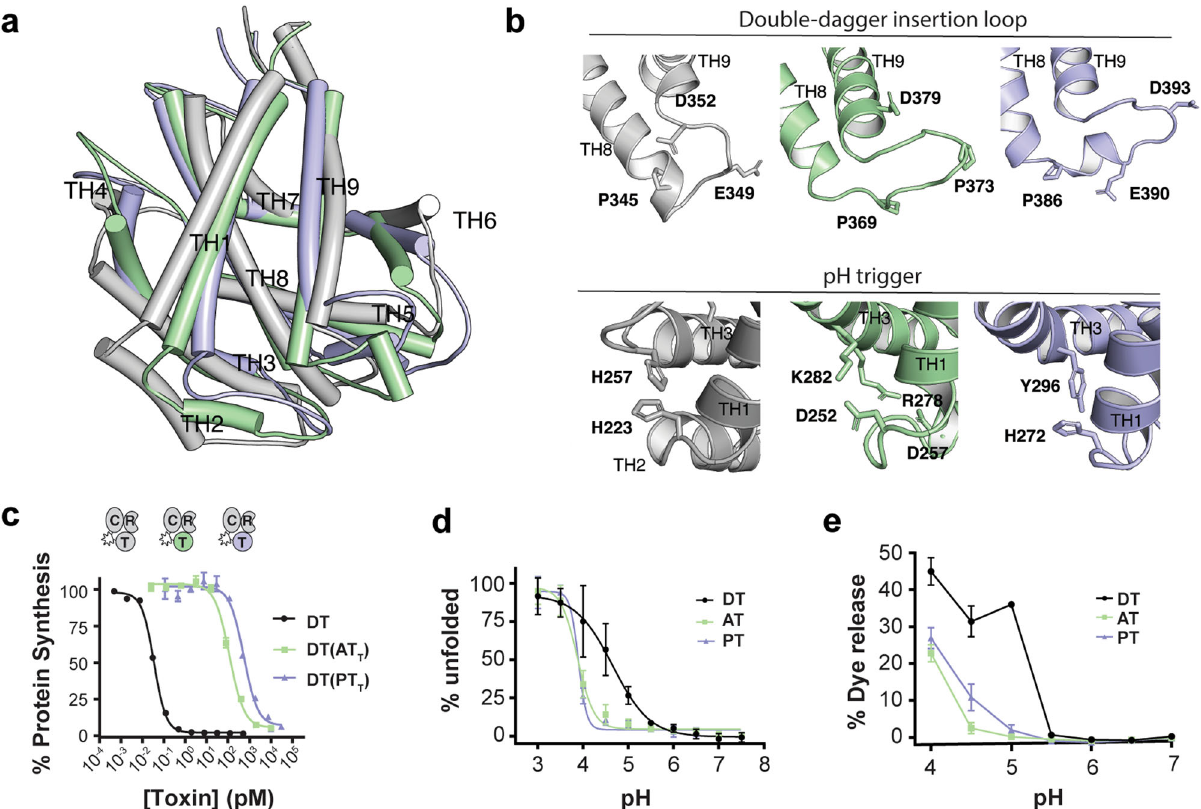
Fig. 6 AT and PT have functional translocases with altered pH dependence. a Overlay of T-domain structures (AT: 20% sequence identity, RMSD 3.0 Å; PT: 31% sequence identity, RMSD 3.1 Å). b Residues of interest in the TH8/TH9 loop involved in initial membrane insertion of DT T (top). AT and PT contain an equivalent to DT P345 (AT P369 and PT P386 ). The loop in AT contains a three-residue insertion and an additional Pro residue within the loop (AT P373 ), and only one negatively charged residue (AT D379 ). PT P386 causes a 90° kink in TH8, which continues for a full turn before terminating with a Glu residue (PT E390 ). Residues of interest at the junction of TH1, TH2, and TH3 believed to play an important role in early destabilization of DT T (bottom). AT T contains two salt-bridges (D252/R282, D257/K278) in lieu of His residues in this junction. c Toxicity of chimeric toxins on Vero cells. Dose titration of DT and DT T-domain chimeras DT(AT T ), and DT(PT T ) on Vero cells (mean ± SD, n = 2); n = 3 biological replicates. d pH dependent TNS analysis (mean ± SD, n = 3). e pH-dependent dye leakage from liposomes loaded with fl uorophore quencher pair (HPTS/DPX). DT exhibits a spike of activity upon exposure to pH 5, while AT and PT are only active at pH 4, a full pH unit lower than DT (mean ± SD, n = 4); n = 3 biological